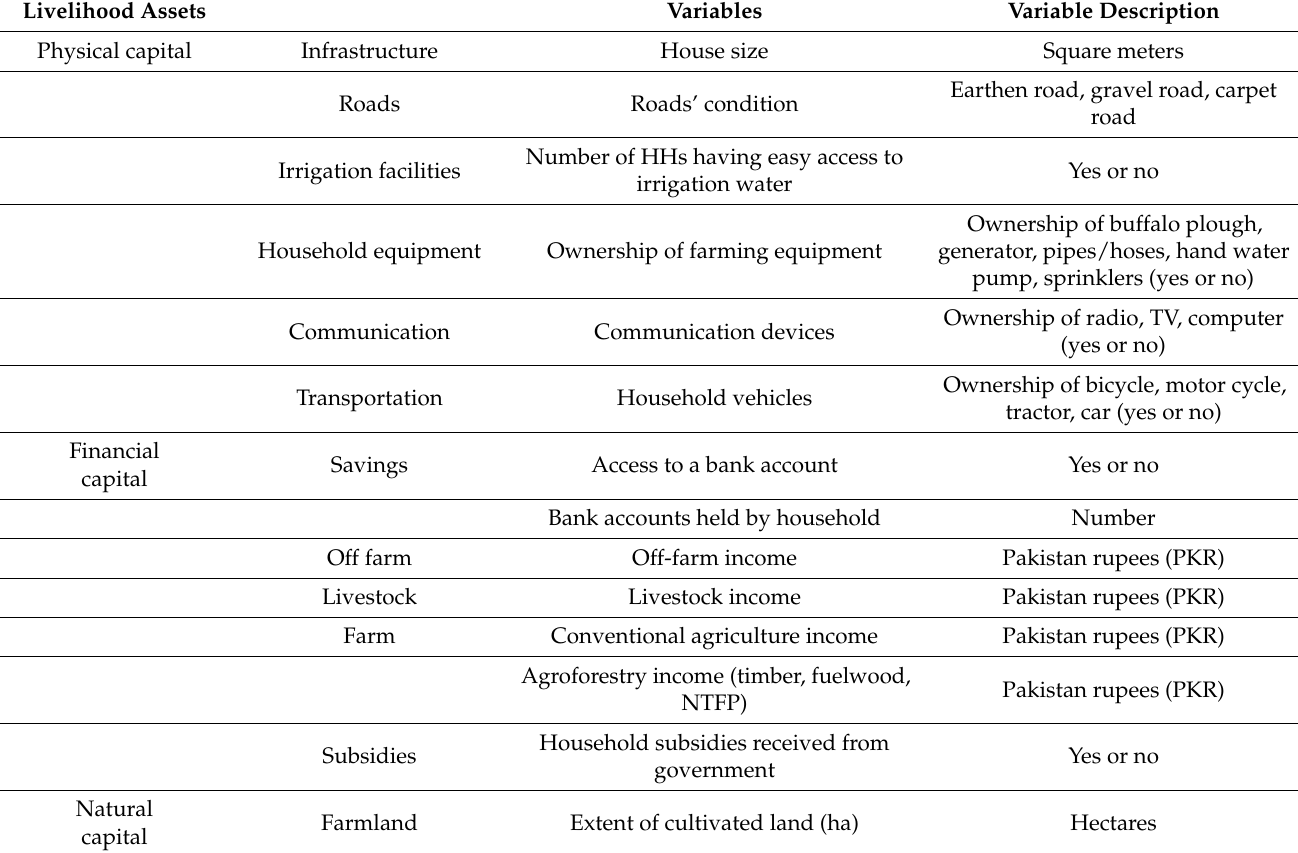
Table 1. Detailed description of the five capitals used in the livelihood